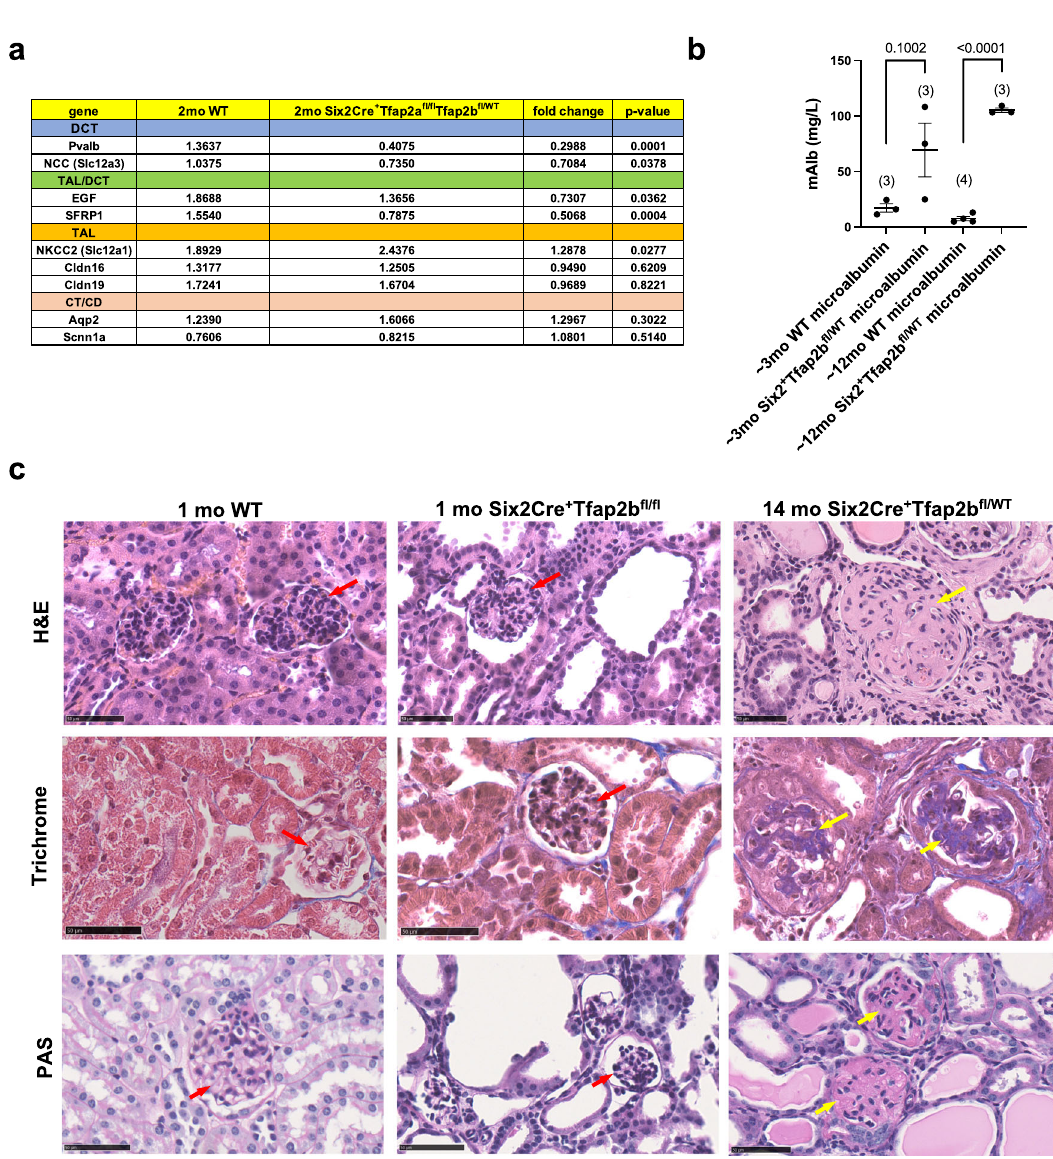
Fig. 8 Severe glomerulosclerosis in aged Six2Cre + Tfap2b fl /WT mice. a Semiquantitative RT-PCR with whole kidney lysates of 2-months-old Six2Cre + Tfap2a fl / fl Tfap2b fl /WT mice and WT littermates. Expression of DCT markers Pvalb and Slc12a3 is strongly reduced in kidneys of Six2Cre + Tfap2a fl / fl Tfap2b fl /WT mice, as is the expression of genes that are expressed in both TALs and DCTs ( Egf , Sfrp1 ). The TAL marker Slc12a1 is upregulated in these kidneys, whereas the expression of CT/CD markers ( Aqp2 , Scnn1a ) is unchanged. N = 9 kidneys per group. P values are shown (two-tailed, unpaired t test). Source data are provided as a Source Data File. b An increase in urinary microalbumin is observed in aged Six2Cre + Tfap2b fl /WT mice. P values are shown (two-tailed t test). Graph represents data as mean ± SEM. Each dot represents a different mouse. Number of mice per group is indicated in brackets. Source data are provided as a Source Data File. c H&E, Trichrome, and PAS staining of kidneys form a 1-months-old WT mouse, a 1-months-old Six2Cre + Tfap2b fl / fl mouse, and a 14-months-old Six2Cre + Tfap2b fl /WT mouse. Whereas glomeruli show no glomerulosclerosis in the 1-months-old Six2Cre + Tfap2b fl / fl mouse kidney (red arrows), eosinophilic, PAS + , and Trichrome + staining is observed in glomeruli with strong expansion of the glomerular matrix in the 14- months-old Six2Cre + Tfap2b fl /WT mouse kidney (yellow arrows), consistent with severe glomerulosclerosis. Scale bars, 50 μ